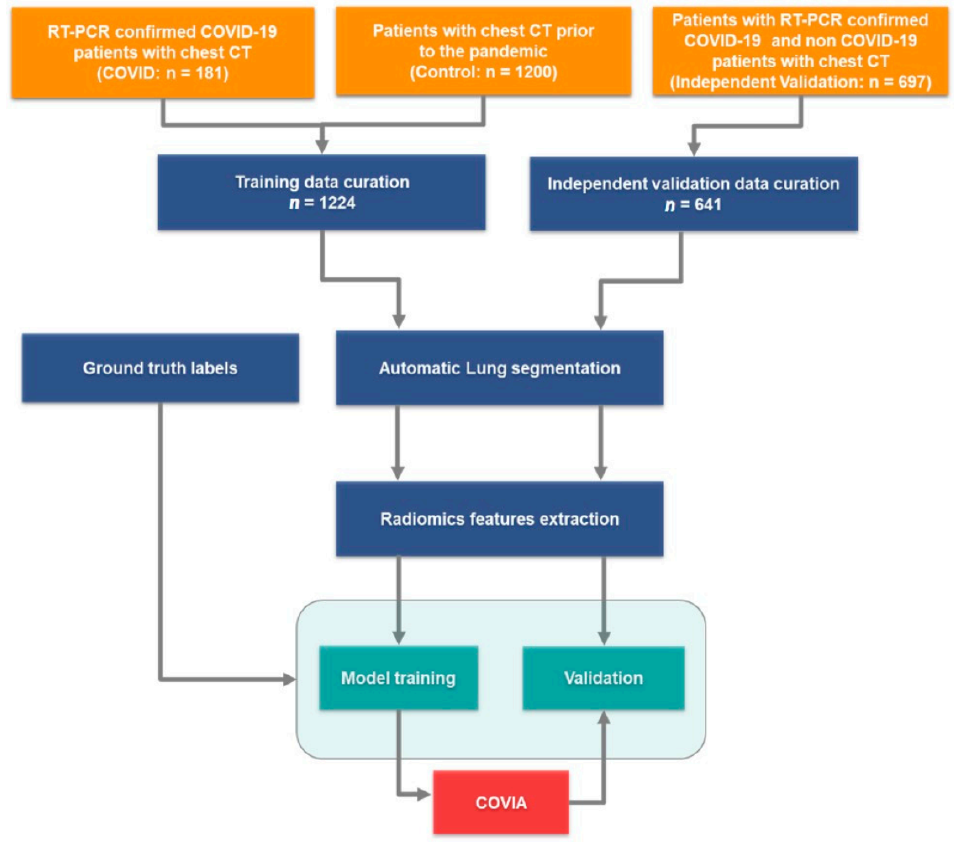
Figure 3. Flow diagram: Training and validation data were collected, the COVID and Control cohorts were combined. Lungs were segmented from both the training and validations datasets, respectively, and radiomics features were extracted. The independent validation data was used to test the performance of coronavirus intelligence artificielle (COVIA) with unseen patient